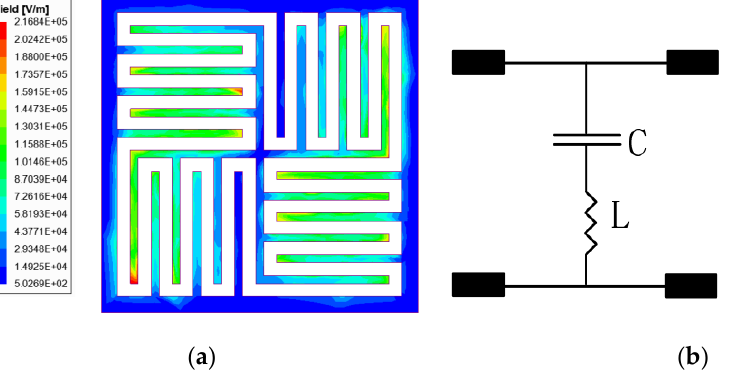
Figure 5. Resonance of the stripe at 7.3 GHz: ( a ) schematic diagram of surface electric field ( b ) equivalent circuit model diagram.